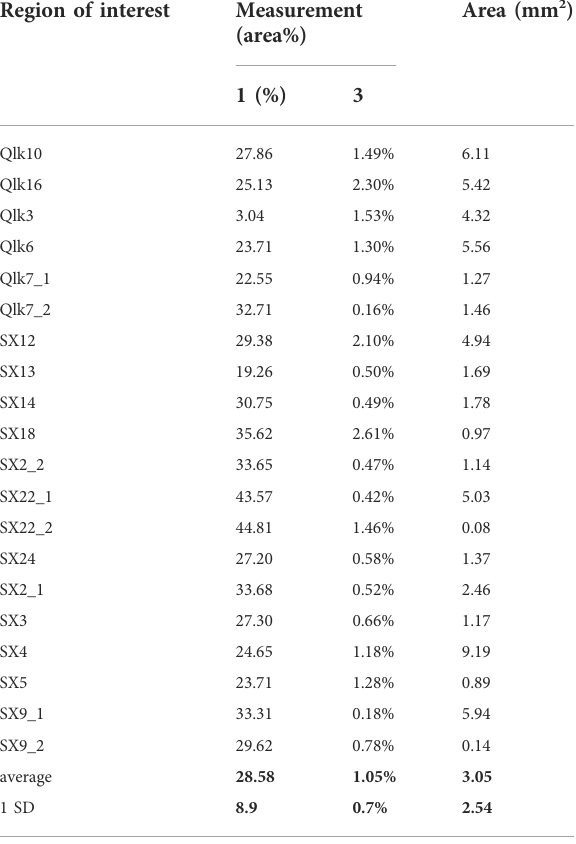
TABLE 2 Unclassi fi ed proportion obtained from one mineral mode versus three minerals mode. Region of interest